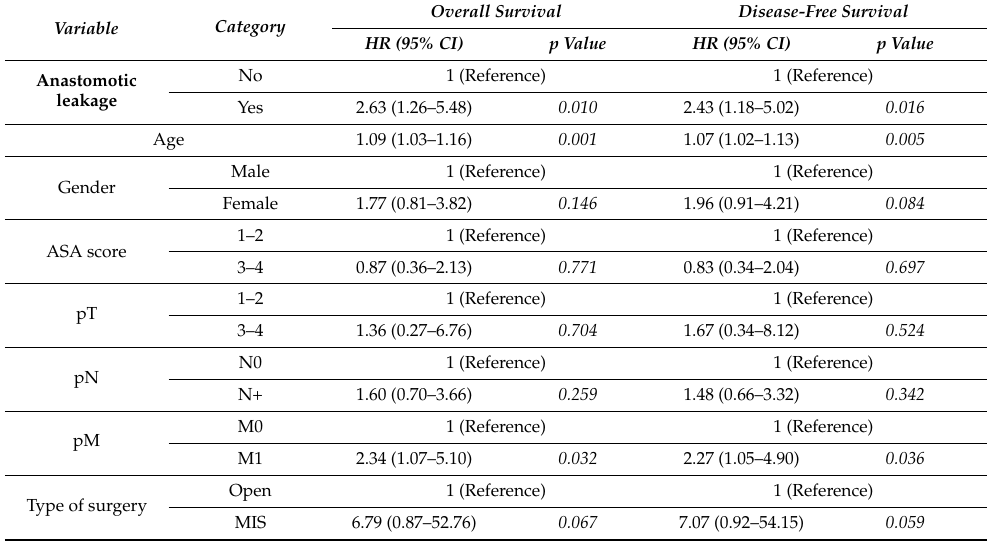
Table 4. Multivariable Cox regression analysis for overall and disease-free survival in the propensity- score-matched